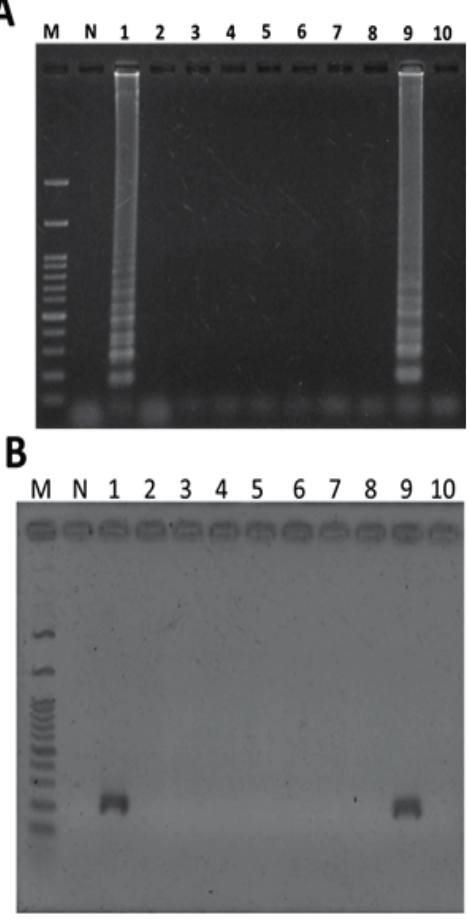
Figure 6. Diagnostic authentication of commercial plants of Taraxacum formosanum from various herbal markets using LAMP method ( A ) and PCR ( B ). Ten plants of Taraxacum formosanum obtained from various herbal markets were used for rapid authentication using the LAMP method after adding plant genomic DNA. Lane M, 1 kb of DNA ladder marker; lane N, genomic DNA of Ixeris chinensis ; lane 1–10, ten commercial plant of Taraxacum formosanum from various herbal